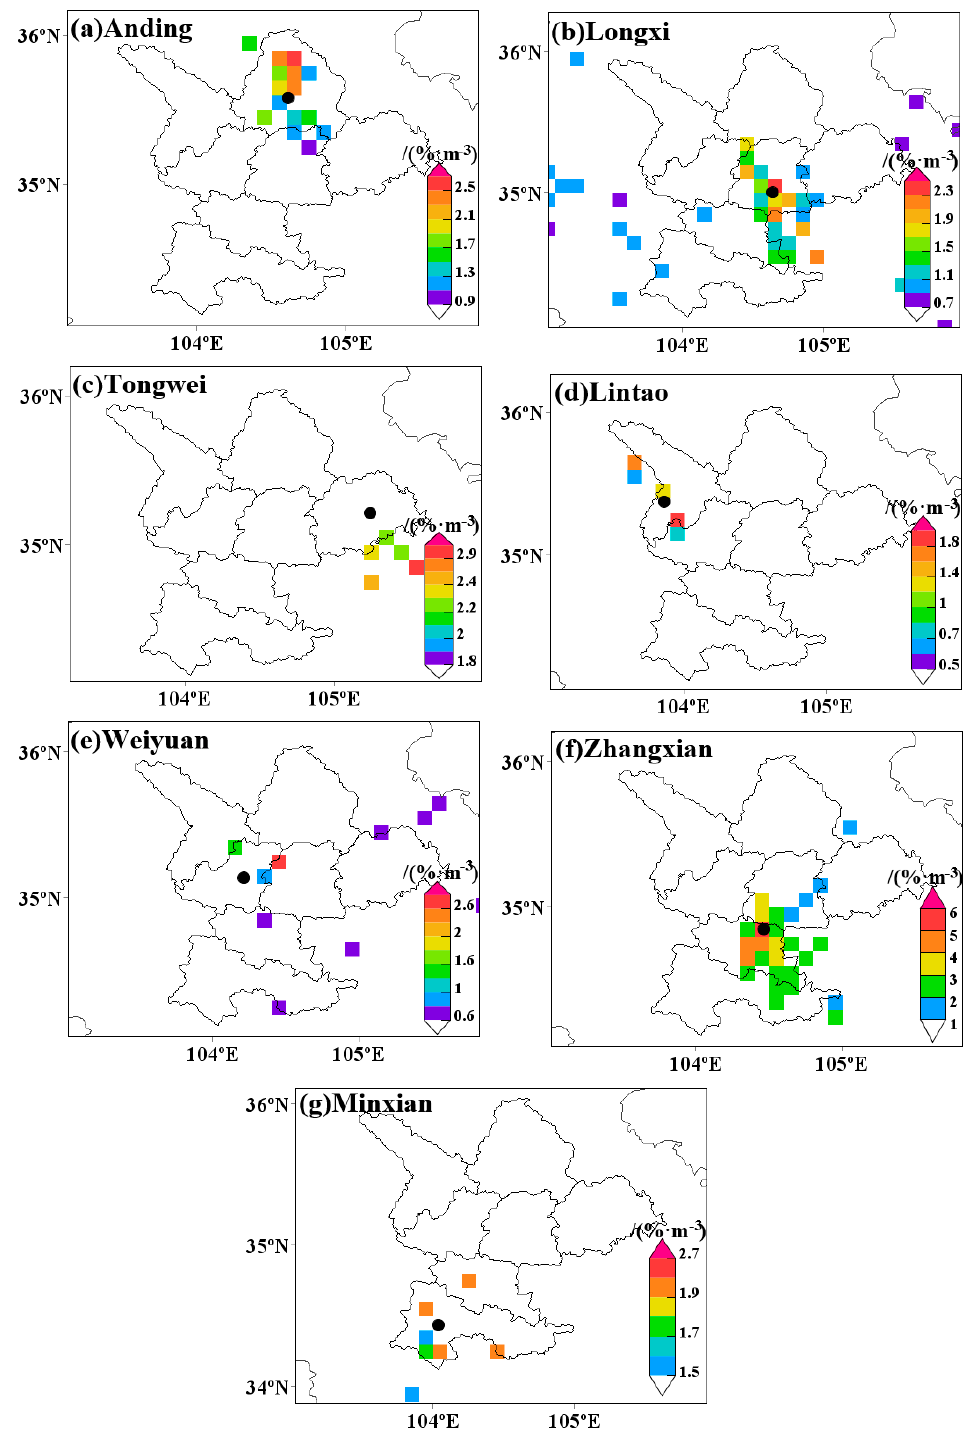
Figure 6. C Map showing the CWT analysis of ( a ) Anding, ( b ) Longxi, ( c ) Tongwei, ( d ) Lintao, ( e ) Weiyuan, ( f ) Zhangxian and ( g ) Minxian stations during the monsoon period. ( e ) Weiyuan, ( f ) Zhangxian and ( g ) Minxian stations during the monsoon